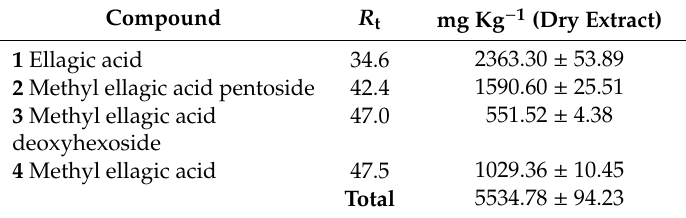
Figure 1. HPLC-UV (252 nm) phenolic profile of the methanolic extract obtained from H. bhamoense trunk bark. Identity of compounds as in Table 1. Table 1. Content of ellagic acid and derivatives on the methanol extract of H. bhamoense trunk bark.